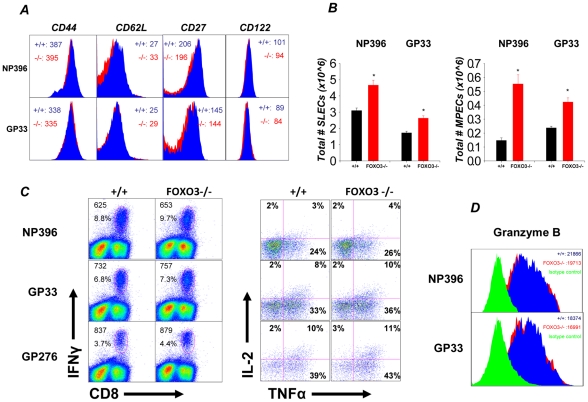
Absence of FOXO3 does not affect the phenotype or function of effector CD8 T cells.(A) At 8 days after LCMV infection, splenocytes from +/+ and FOXO3−/− mice were isolated and stained for expression of CD44, CD62L, CD27 and CD122 on NP396- (top) and GP33- (bottom) specific CD8 T cells. Representative histograms in panel A are gated on CD8 and MHC-I tetramer positive populations with the numbers indicating MFI for the indicated protein in either +/+ or FOXO3−/− mice. (B) Total splenocytes were stained with MHC-I tetramer, anti-CD8, anti-CD127 and anti-KLRG-1, and the total number of SLECs (KLRG-1high/CD127low) and MPECs (CD127high/KLRG-1low) were quantified by flow cytometry. Data are from 4 to 6 independent experiments with 3–6 mice/group/experiment; error bars represent the SEM and * indicates statistical significance at p<.05. (C) On day 8 PI, Splenocytes from +/+ or FOXO3−/− mice were stimulated with LCMV epitope peptides for 5 hours directly ex-vivo. Following stimulation, cells were stained for cell surface CD8 and intracellular IFNγ, IL-2 and TNFα. Panel C shows cytokine production by effector CD8 T cells. Representative dot plots (left) are gated on total lymphocytes with the top number indicating observed MFI for IFNγ staining in peptide-stimulated CD8 T cells and the bottom number indicating percentage of total splenocytes that are CD8 and IFNγ positive. Dot plots (right) represent the percentage of IL-2 and/or TNFα producing cells among IFNγ+ve CD8 T cells. (D) Intracellular staining for Granzyme B. The FACS histograms are gated on LCMV-specific CD8 T cells from +/+ (BLUE) and FOXO3−/− (RED) mice. The green histogram represents staining with isotype control antibodies. The data are MFIs for Granzyme B expression +/− SD.